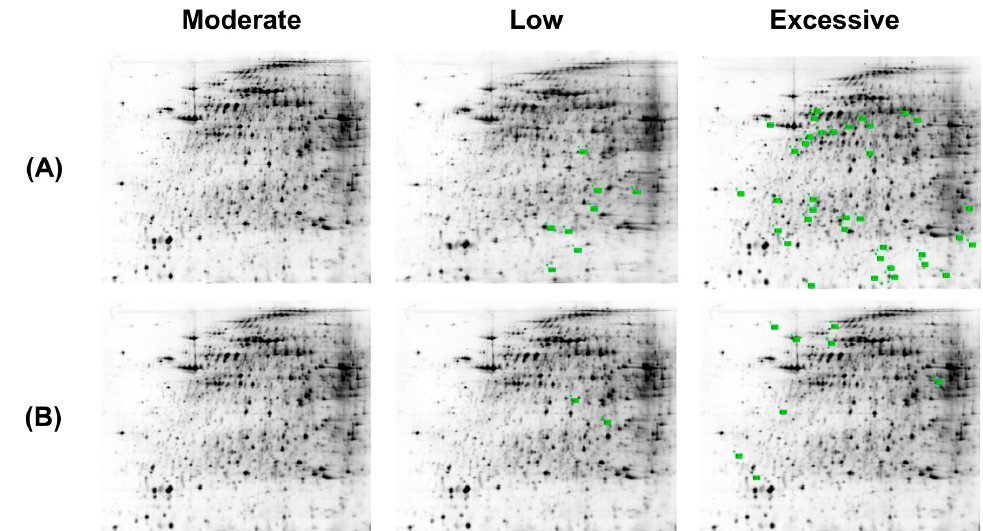
Figure 3. Two-dimensional electrophoresis of differentiable proteins in mitochondria. Mitochondria were extracted from the livers of mice with low, excessive or moderate levels of selenium diets. ( A ) Proteins that differed in amount by ≥ 1.5-fold increase, relative to the control, are indicated in green; and ( B ) proteins that differed in amount by ≥ 1.5-fold decrease, relative to the control, are indicated in green.